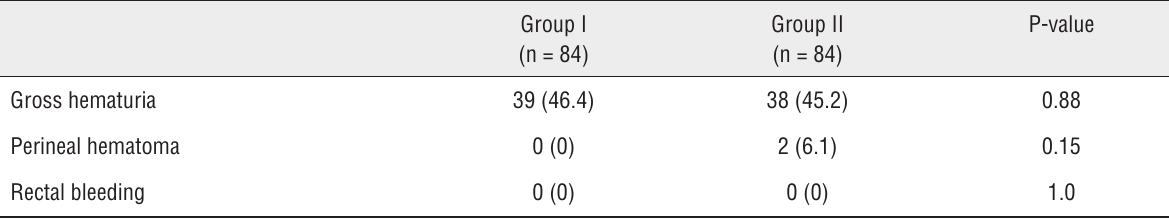
Table 4 - Incidence of bleeding associated events after